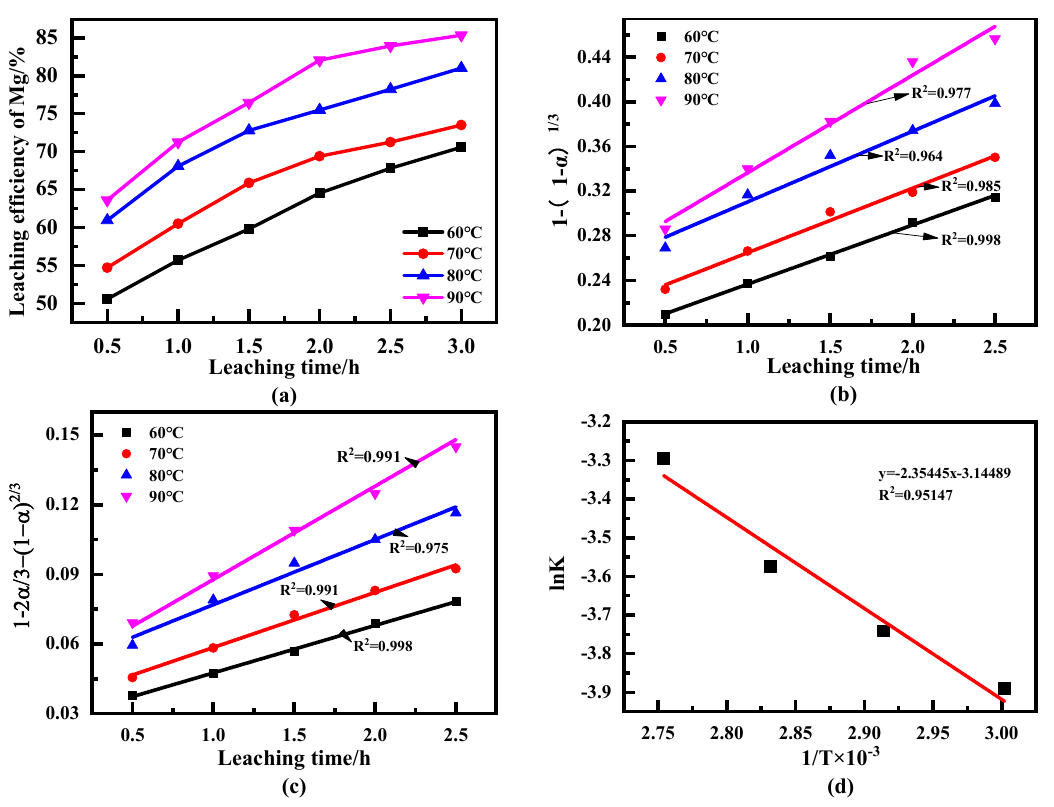
Figure 7. ( a ) Relationship between Mg leaching efficiency and leaching time; ( b ) plots of 1 − (1 − α)1/3 vs. time for magnesium leaching; ( c ) plots of 1 − 2α/3 − (1 − α)2/3 vs. time for magnesium leaching; ( d ) Arrhenius plot of the solid membrane diffusion-controlled model.